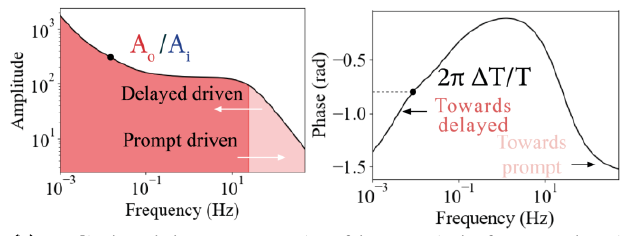
Figure 1. Simulated zero-power reactor behavior in a modulation experiment